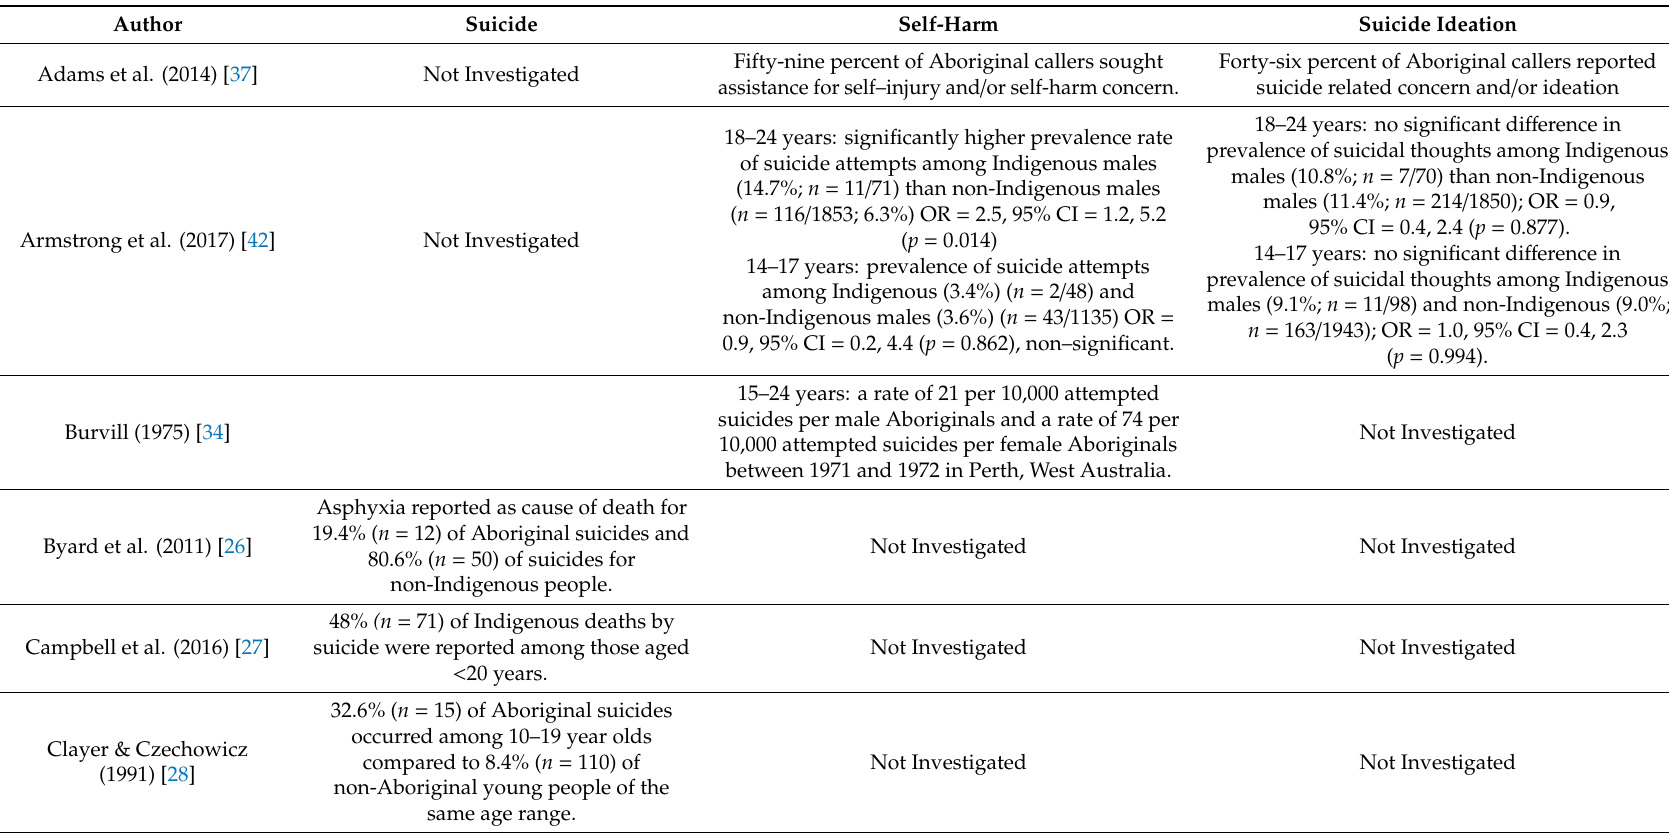
Table 3. Prevalence of suicide, self-harm and suicide